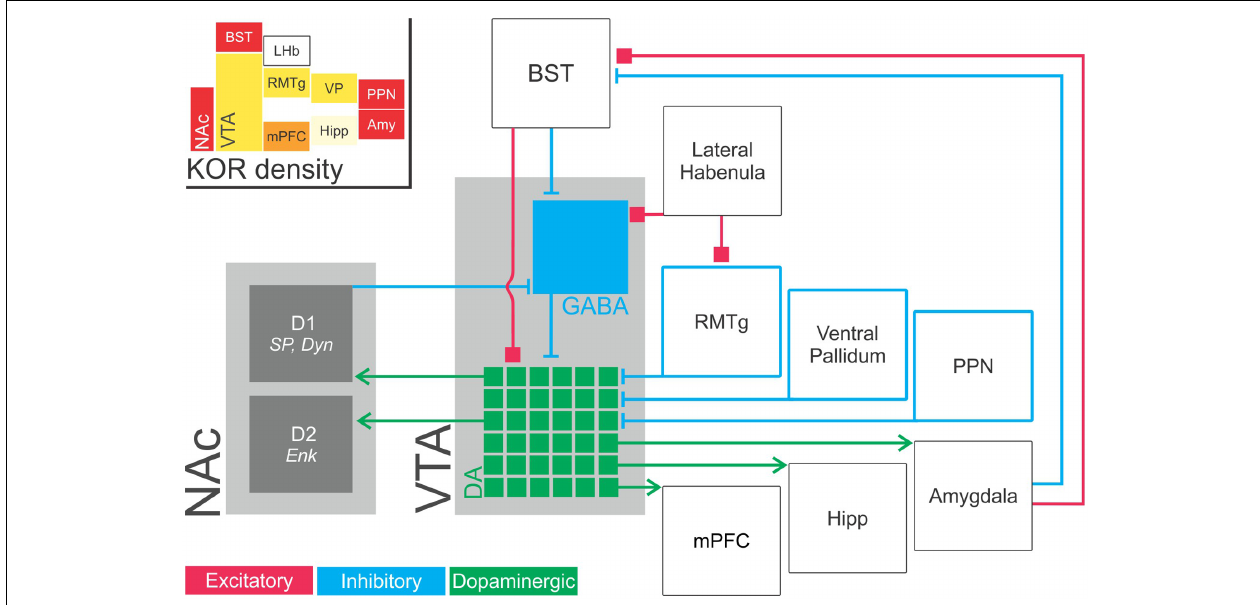
GABAergic interneurons within the ventral tegmental area itself (blue). GABAergic projections to theVTA has been identified from the NAc (Nauta etal., 1978); ventral pallidum (Haber etal., 1985); RMTg (Jhou etal., 2009) and the pedunculopontine tegmental nucleus/lateral dorsal tegmentun (Omelchenko and Sesack, 2005; Good and Lupica, 2009).These neurons are also modulated by excitatory inputs (red) from the bed nucleus of the stria terminalis (Georges and Aston-Jones, 2001, 2002;Watabe-Uchida etal., 2012). (Inset) KOR abundance in these structures. Heat map color-coded (Red = most abundant) by reported radioligand binding (Mansour etal., 1987; Le Merrer etal., 2009). Amy, amygdala; BST, bed nucleus of the stria terminalis, D1, dopamine receptor D1; D2, dopamine receptor D2; Enk, enkephalin; Hipp, hippocampus; LHb, lateral habenula; mPFC, medial prefrontal cortex; NAc, nucleus accumbens; PPN, pedunculopontine nucleus/pedunculopontine tegmental nucleus; RMTg, rostromedial tegmental nucleus;VP, ventral pallidum; SP, substance P;VTA, ventral tegmental